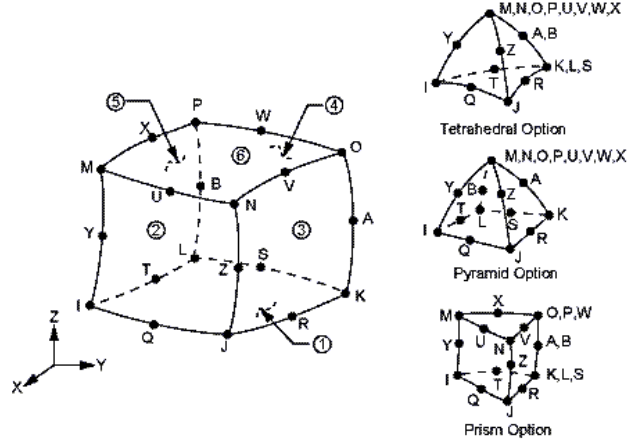
Figure 2. Geometry options and location of nodes for solid186